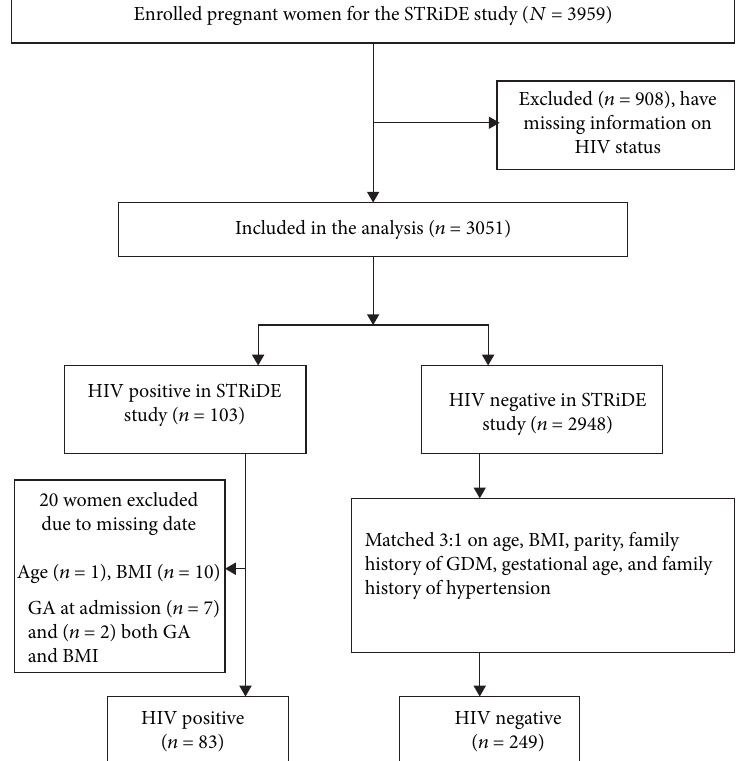
Figure 1: Flow chart for identi fi cation and analysis of